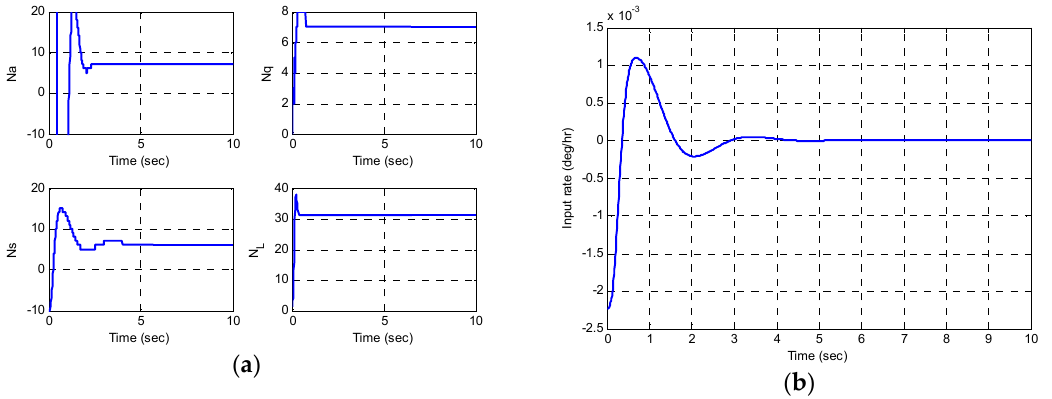
Figure 14. Matlab/Simulink simulation results: ( a ) the digital optputs to control; ( b ) an estimate of the input rate.